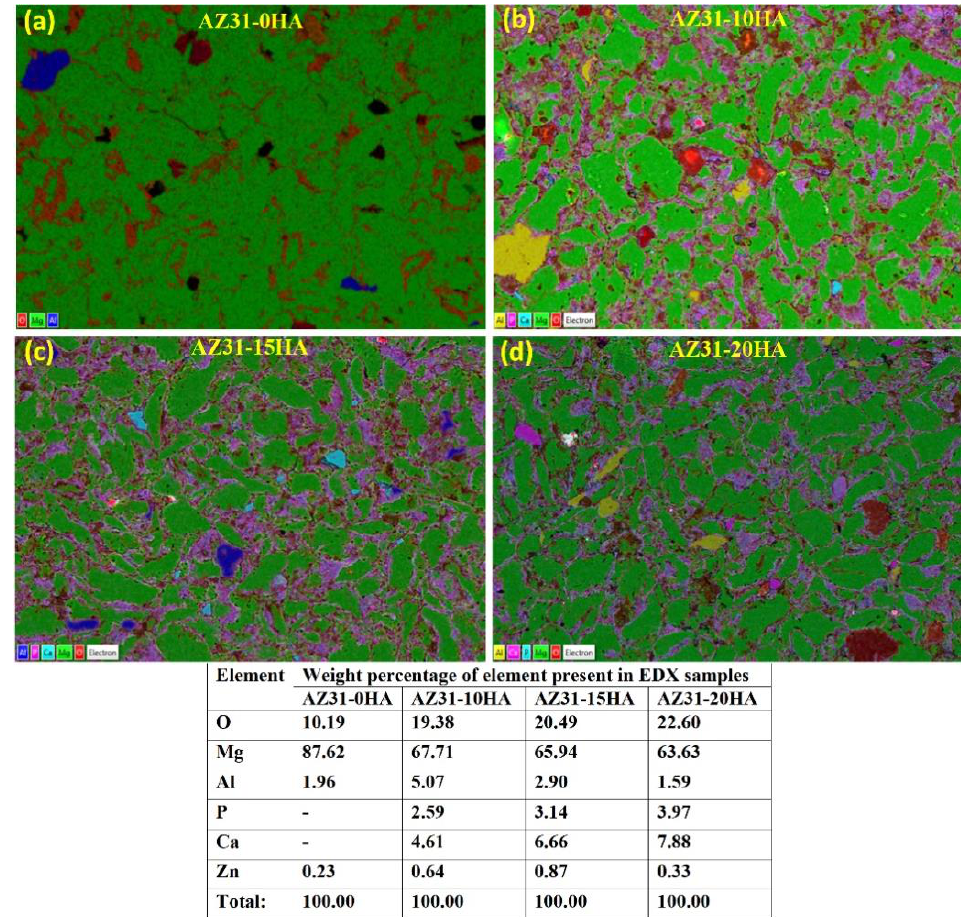
Figure 7. Elemental mapping of AZ31-HA BMMCs from energy-dispersive X-ray spectroscopy along with percentage of element present in the EDX samples (scale: 100 µm).